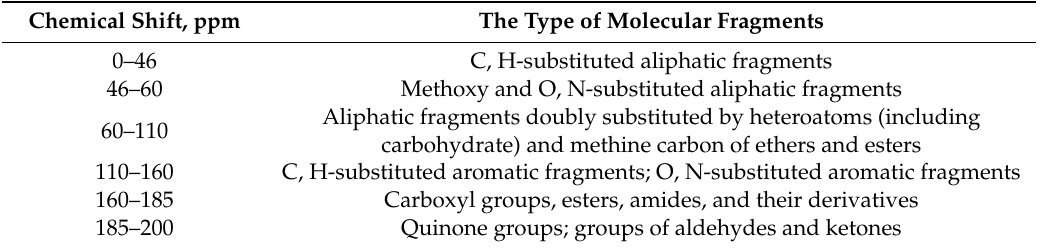
Table 5. Chemical shifts of atoms of the 13 C molecular fragments of humic acids.